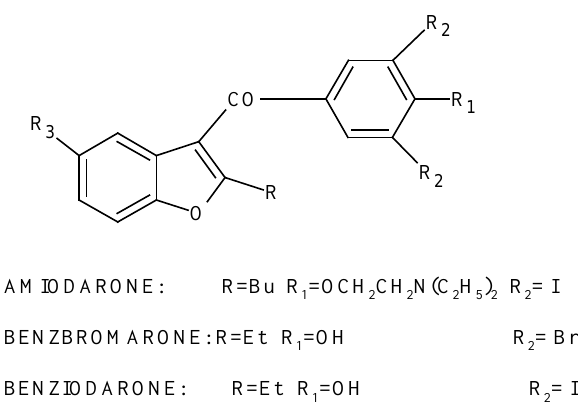
Figure 1. The structures of amiodarone, benzbromarone and benzidarone.